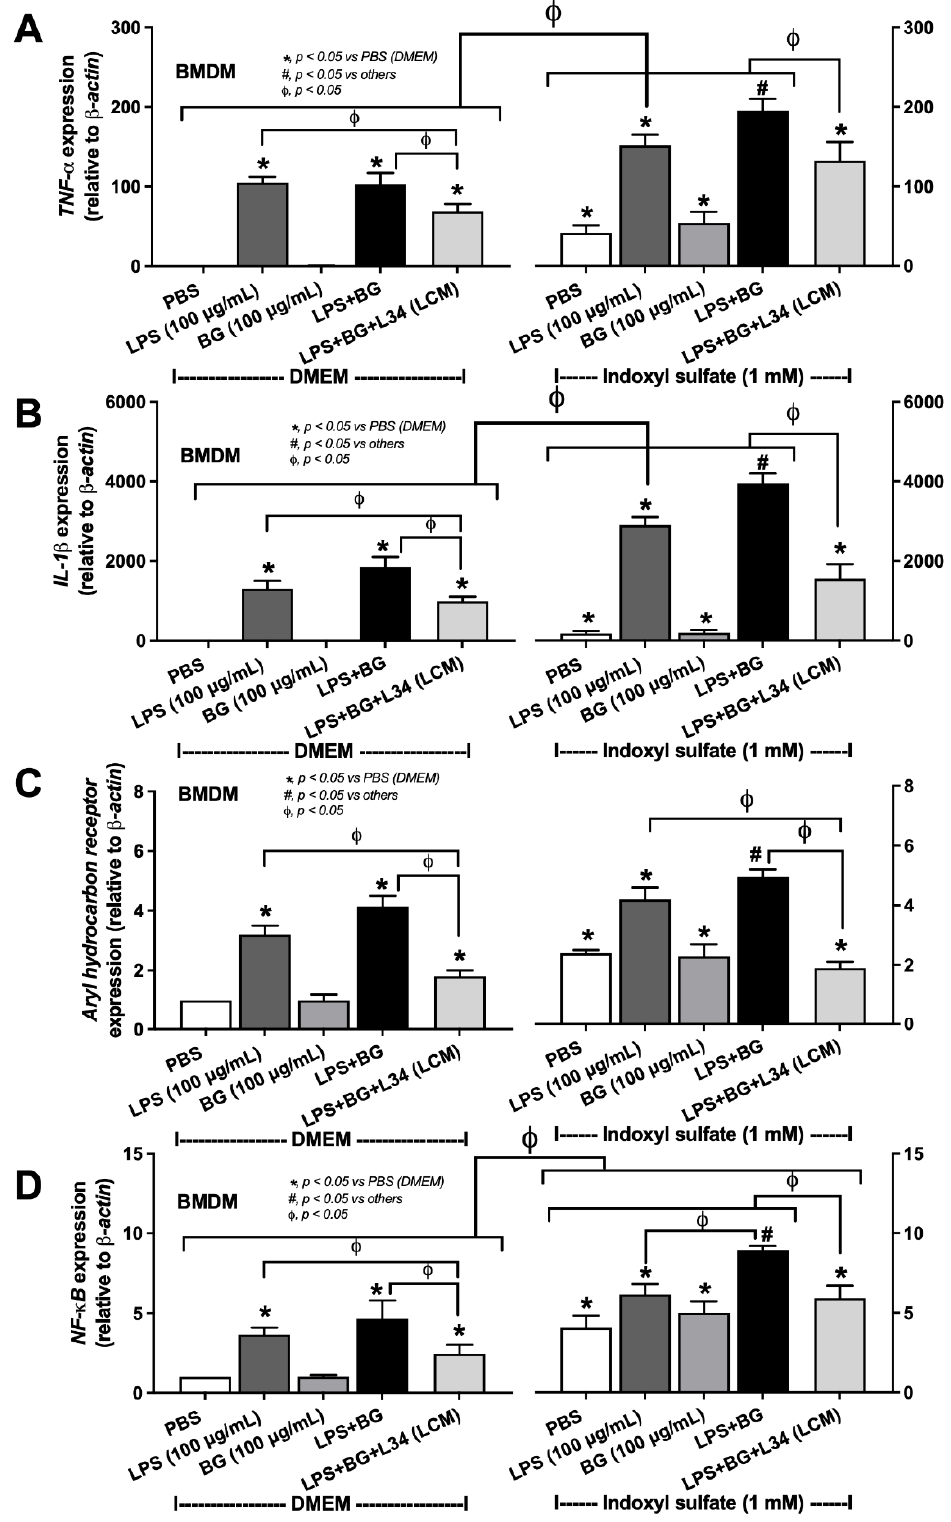
Figure 7. The characteristics of bone marrow-derived macrophages (BMDM) after incubation by indoxyl sulfate at 1 mM, or culture media control (using DMEM), together with lipopolysaccharide (LPS) at 100 µ g/mL with or without (1 → 3)- β -D-glucan (BG) at 100 µ g/mL as indicated by the expression of several genes for inflammatory cytokines: ( A ) TNF- α and ( B ) IL-1 β , and signaling ( C ) aryl hydrocarbon receptor and ( D ) NF- κ B are demonstrated (independent triplicate experiments were performed for the in vitro experiments).